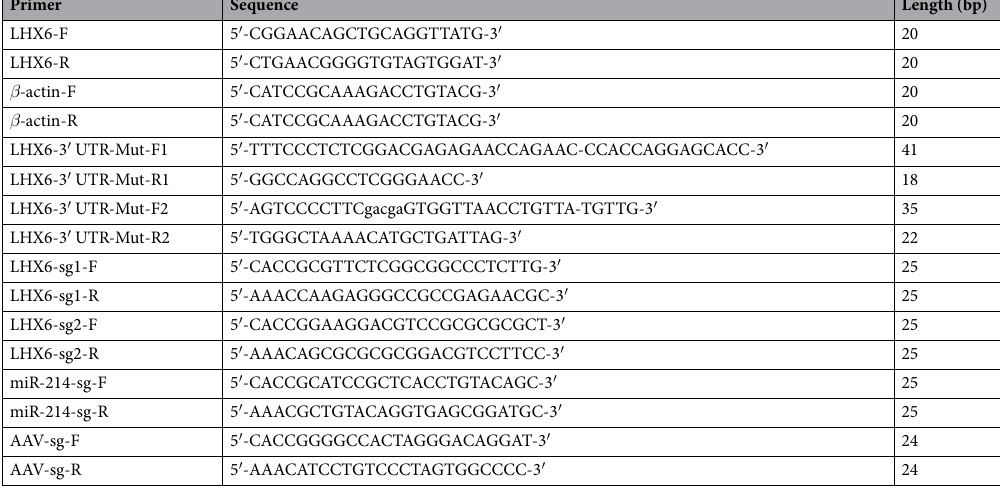
Table 2. Primers and oligos used for qRT-PCR assay, psi-check2 and lentiCRISPR v2